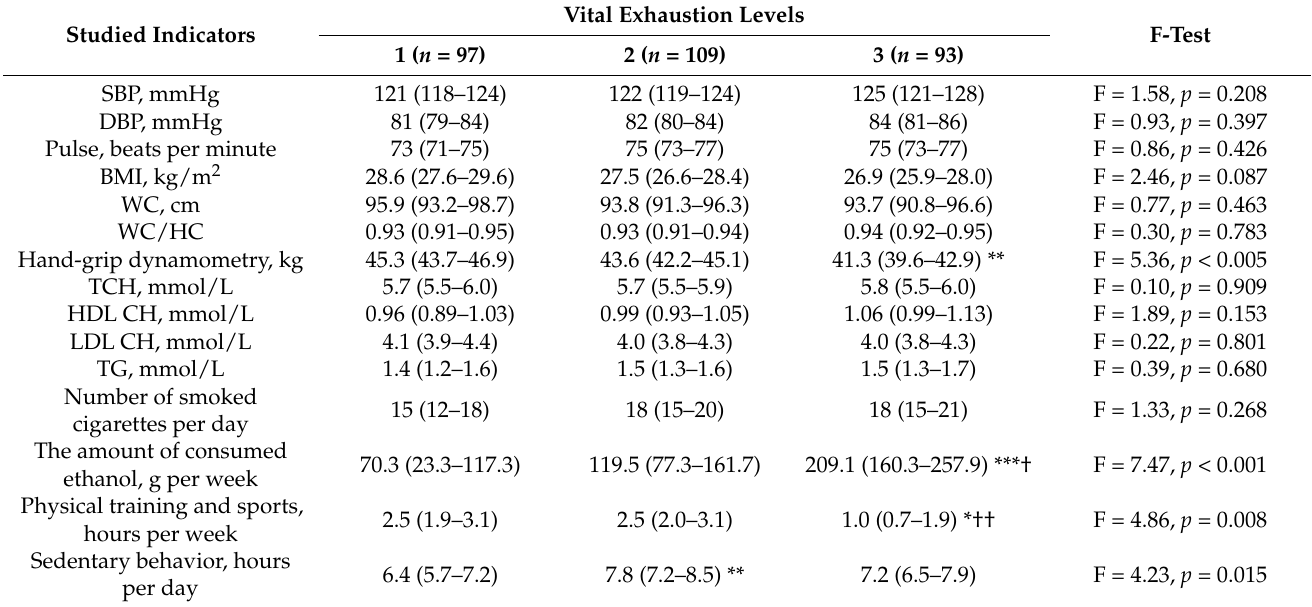
Table 3. Comparative analysis of CVD risk markers in groups of males with different vital exhaustion levels after the correction for the psychosocial stress